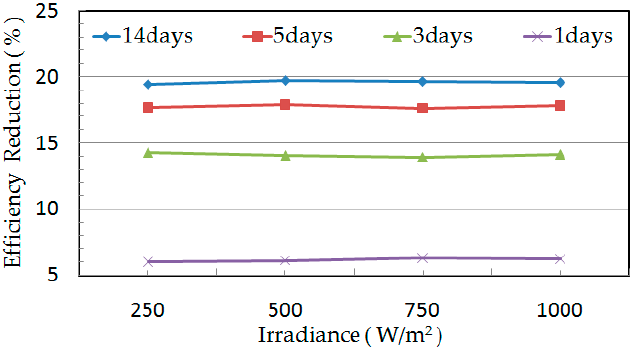
Figure 12. Efficiency reduction of PV panel in different irradiance conditions.